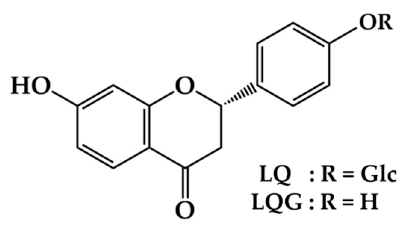
Figure 1. Chemical structures of liquiritin (LQ) and liquiritigenin (LQG).